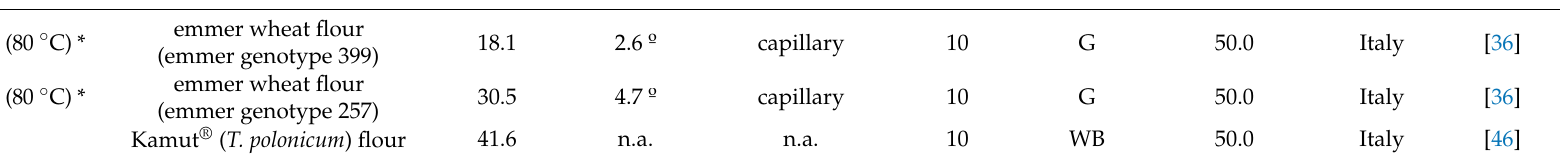
Table 1. Pasta product characteristics, glycemic index and experimental protocol data.